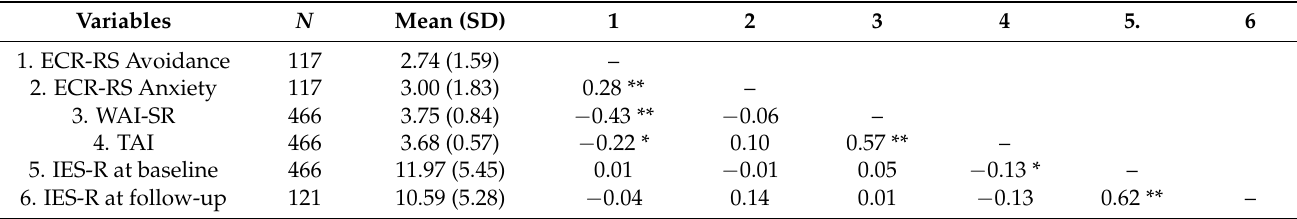
Table 2. Means (Standard Deviations) of Study Variables and Pearson Correlations Between Standardized Variables.